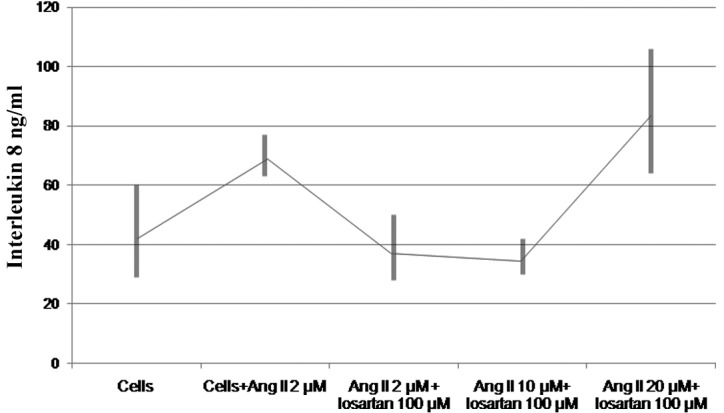
A graphic presentation of the impact of 100 μM of losartan on the interleukin-8 production of THP-1 cells stimulated with various concentrations of angiotensin II (Ang II). Results refer to simultaneous incubation with 100 μM of losartan plus various concentrations of Ang II. Cells represent the naïve state.